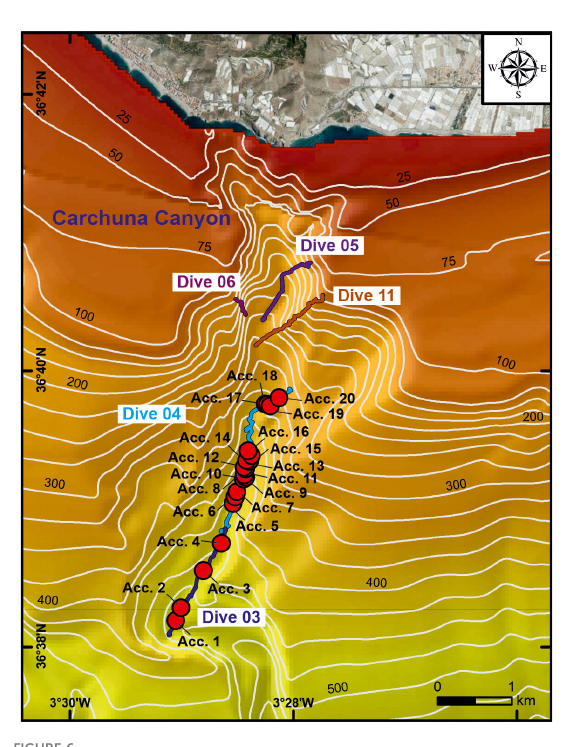
FIGURE 6 Zoomed-in bathymetric map of the study area ( “ Ministerio de Pesca, Agricultura y Alimentacio ́ n ” , Spanish government) showing the location of the litter accumulations found in the Carchuna Canyon. Bathymetric contours in